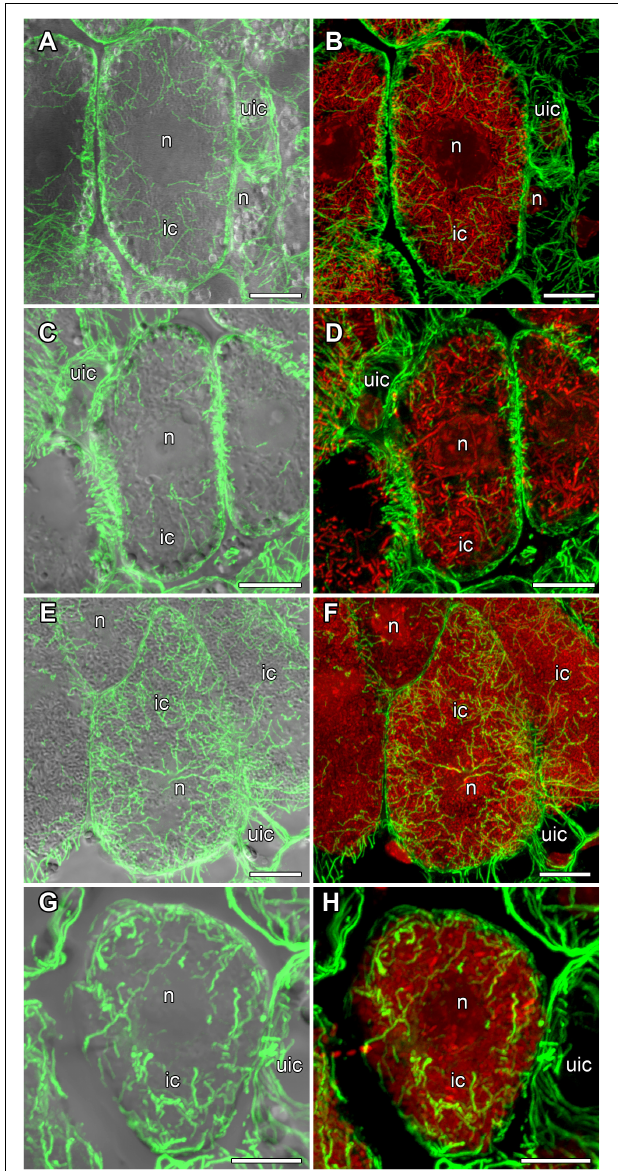
FIGURE 9 | Endoplasmic microtubule organization in infected cells of the nitrogen fixation zone in G. max (A,B) , G. soja (C,D) , P. vulgaris (E,F) , and L. japonicus (G,H) nodules. ic, infected cell; uic, uninfected cell; n, nucleus. Confocal laser scanning microscopy of (A–F) 50 µ m and (G,H) 35 µ m longitudinal vibratome sections. Immunolocalization of tubulin (microtubules), green channel; DNA staining with propidium iodide (nuclei and bacteria), red channel. (A,C,E,G) Merged images of a single optical section of differential interference contrast and maximum intensity projection of optical sections in the green channel. (B,D,F,H) Maximum intensity projections of (B,D) 30, (F) 40, and (H) 30 optical sections in green and red channels. Scale bar = 10 µ m.